Question: Is the quantity shown trending increasing or decreasing?
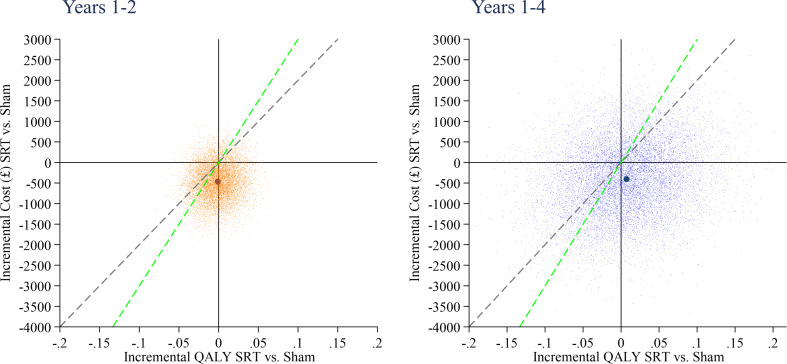
Answer: increasing